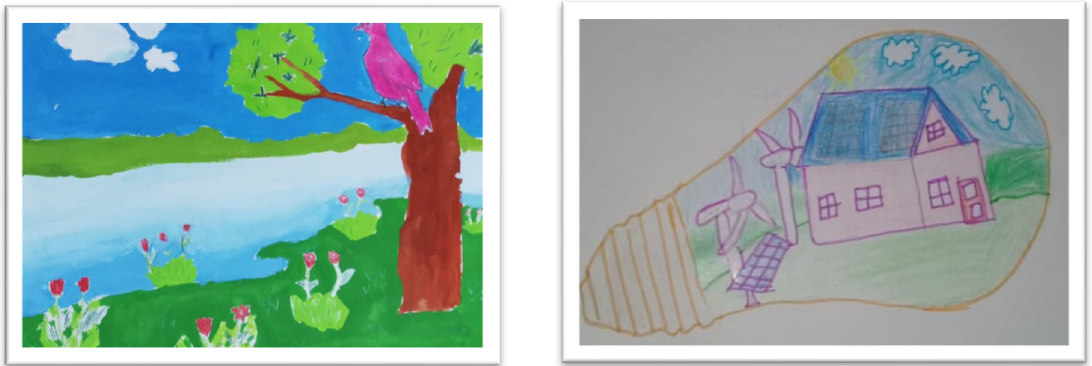
Figure 5. Picture of students’ special